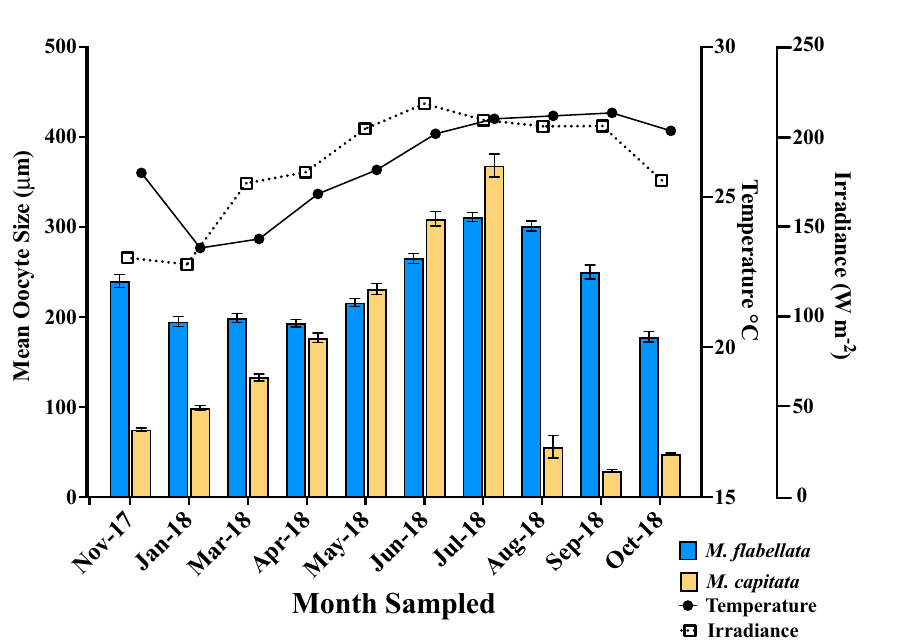
Figure 6. Oogenesis, temperature, and solar radiation. Comparison of mean oocyte size per month with monthly temperature and irradiance means, M. capitata (n = 3 genotypes per month) and M . flabellata (n = 10 genotypes per month). Error bars are ±